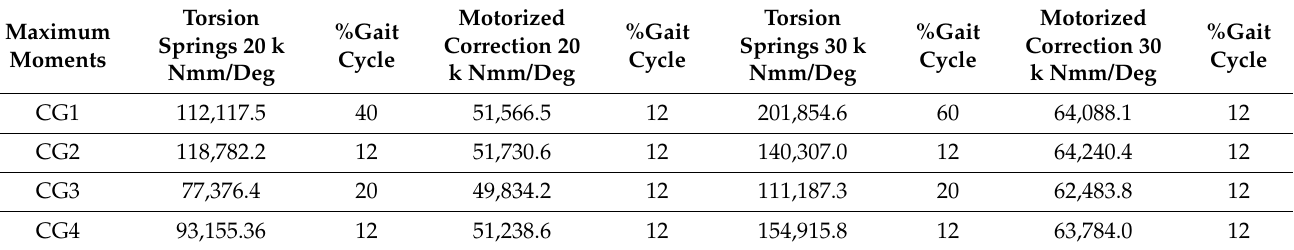
Table 3. Moment maxima taken from simulations for each crouch gait.